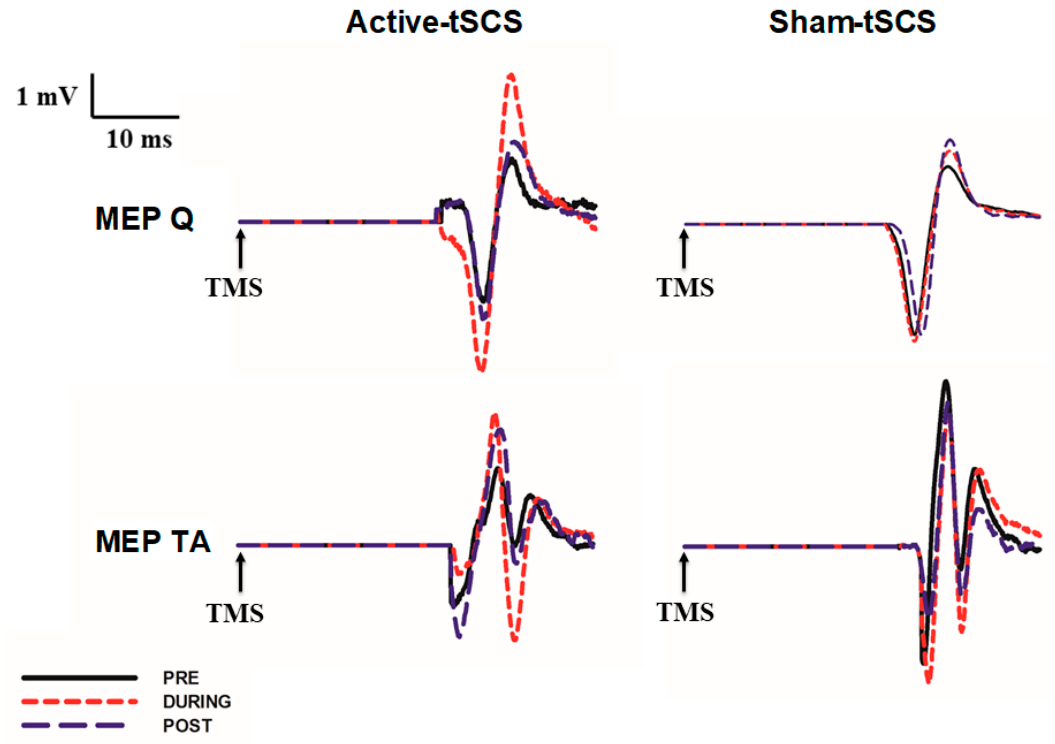
Figure 2. Representative motor-evoked potentials from participant #7 recorded from the Quadriceps and Tibialis Anterior muscles PRE, DURING and POST active or sham tSCS.